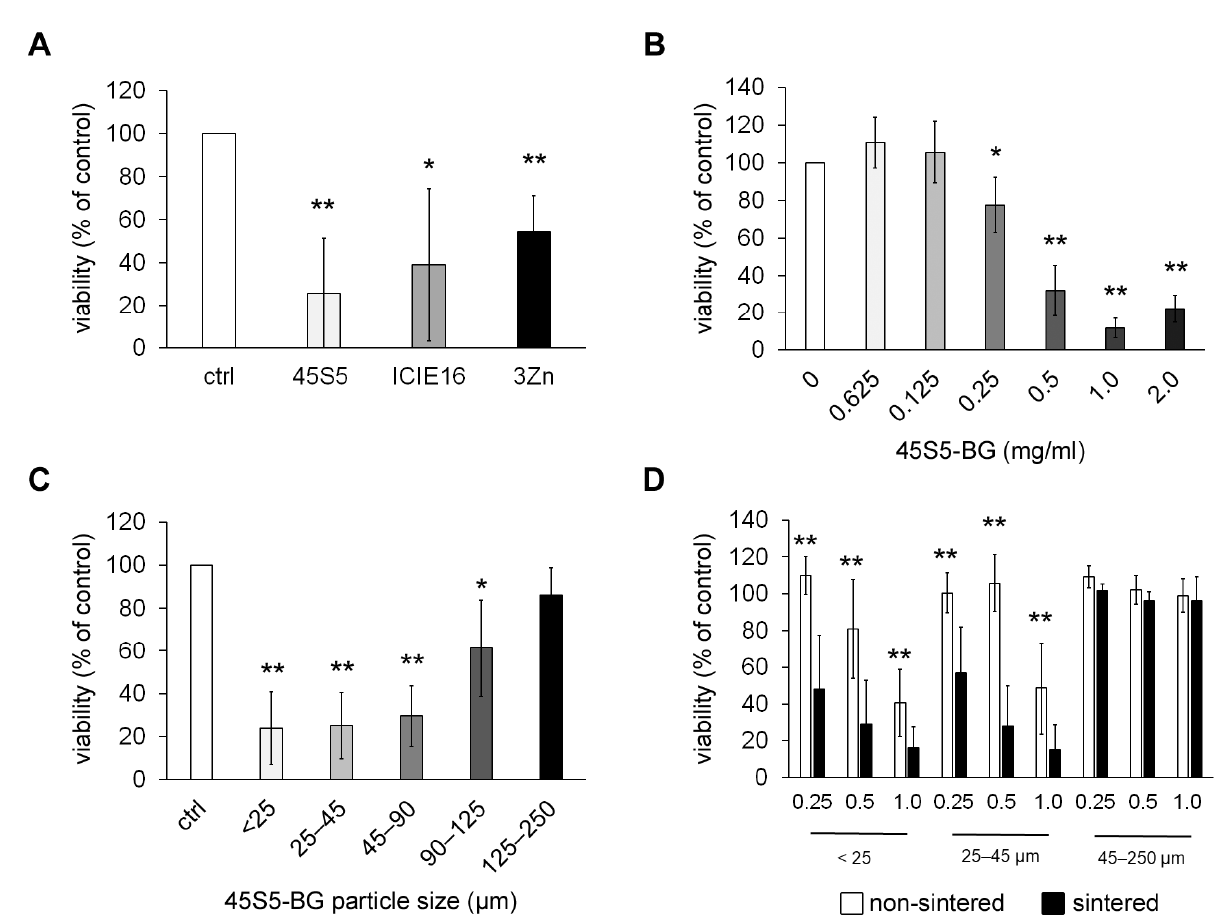
Figure 1. Cytotoxic effects of BGs in vitro. ( A ) GCTSCs ( n = 5) were co-cultured with the indicated BGs at a concentration of 0.5 mg/mL for 72 h. Viability was analyzed by WST-1 assay and is expressed as percent viability compared to untreated control cells. ( B ) GCTSCs ( n = 5) were co-cultured with 45S5-BG for 72 h at the indicated concentrations before cell viability was analyzed by WST-1 assay. ( C ) GCTSCs ( n = 5) were co-cultured with sintered 45S5-BG with the indicated particle sizes at a concentration of 0.5 mg/mL for 72 h. Cell viability was quantified by WST-1 assay. ( D ) GCTSCs ( n = 5) were co-cultured with sintered and non-sintered 45S5-BG, respectively, at the indicated concentrations and particle sizes. Cell viability was analyzed after 72 h. (* p < 0.05, ** p < 0.01).